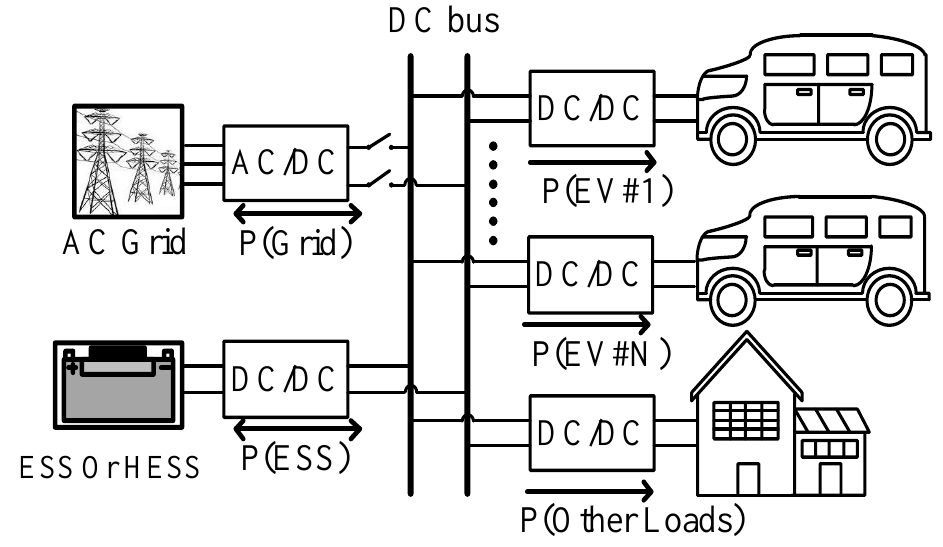
Figure 6. Typical system configuration of a grid-connected ECS with an ESS.